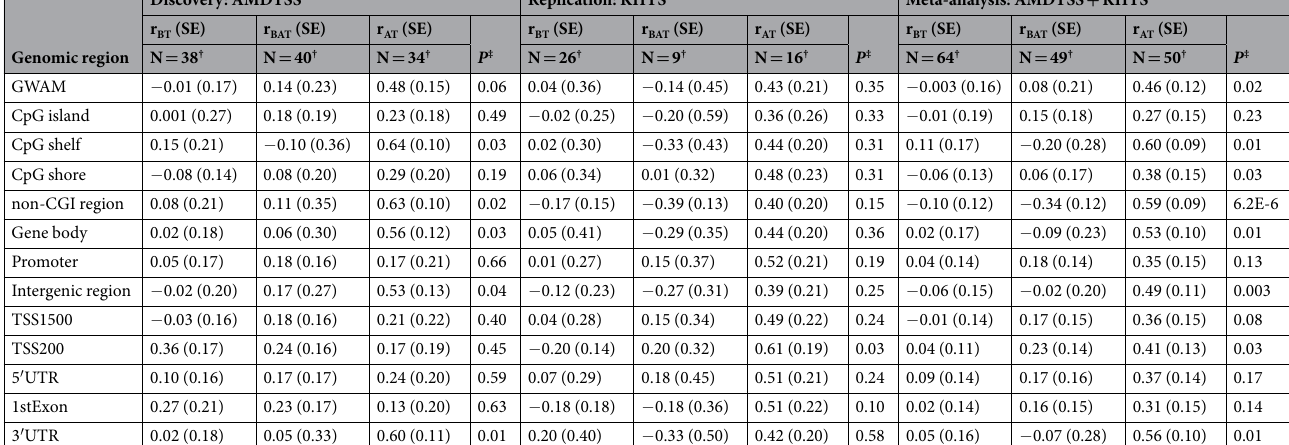
Table 3. Correlations in GWAM and in the average methylation of genomic regions * . * GWAM: genome- wide average methylation; BT: before twin birth; AT: after twin birth; BAT: born on either side of a twin birth;